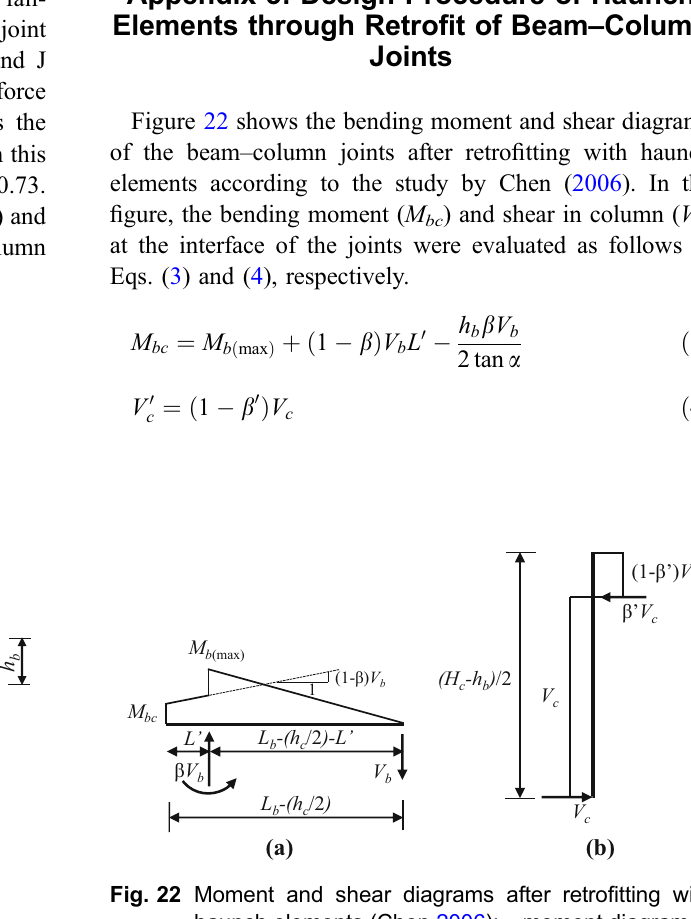
Fig. 21 Force equilibrium in beam–column